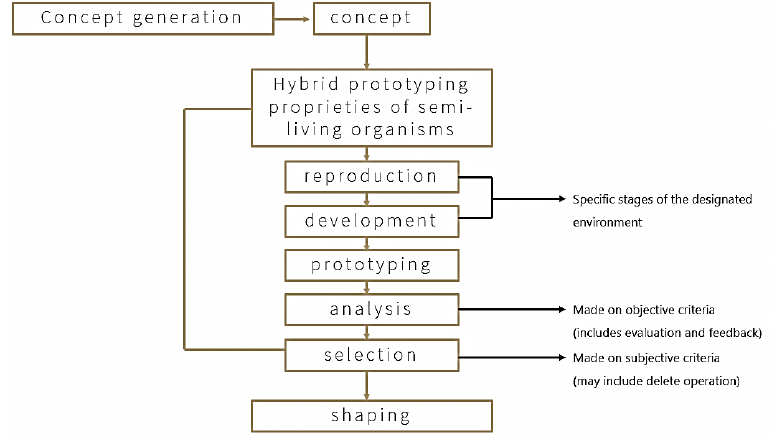
Figure 1. Operations that define the process of the study, creating criteria and hierarchies of